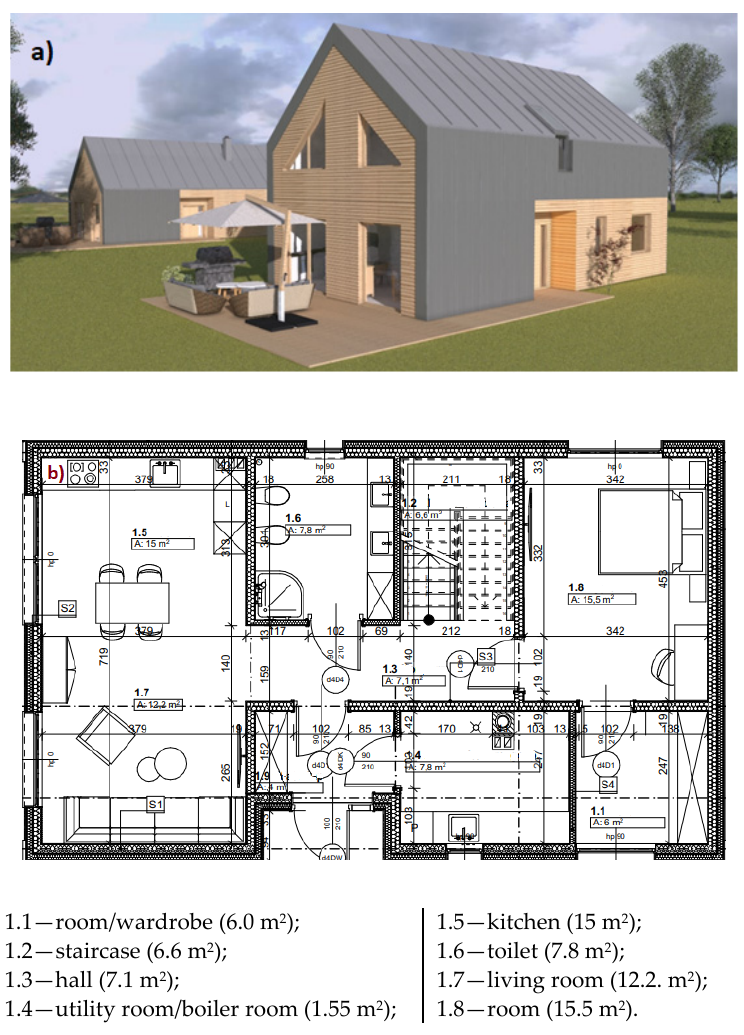
Figure 19. An example of a timber frame building (DomyExpert); ( a ) elevations and view; ( b ) ground floor plan.